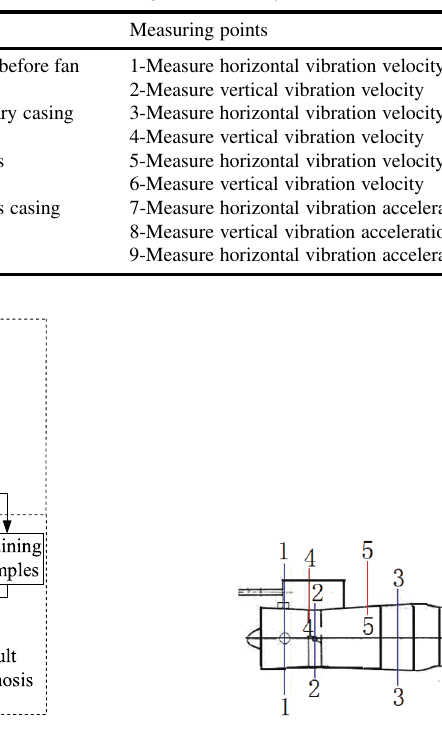
Table 1 Measuring point locations for aeroengine whole-body vibration